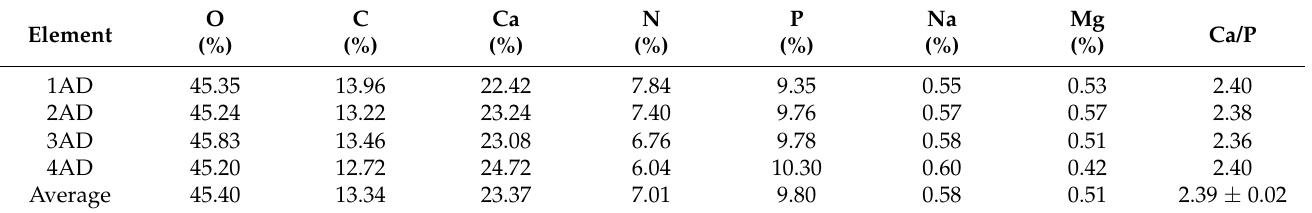
Table 3. The content of elements (mass percentage) for a fine powder made of various types of